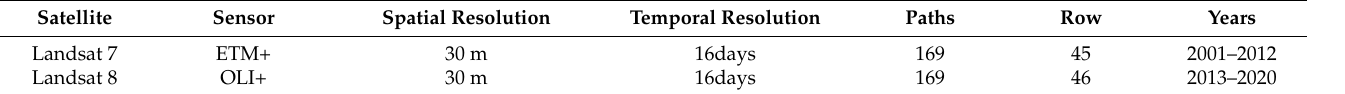
Table 1. Specification of Landsat Satellites over Al-Lith watershed. Satellite Sensor Spatial